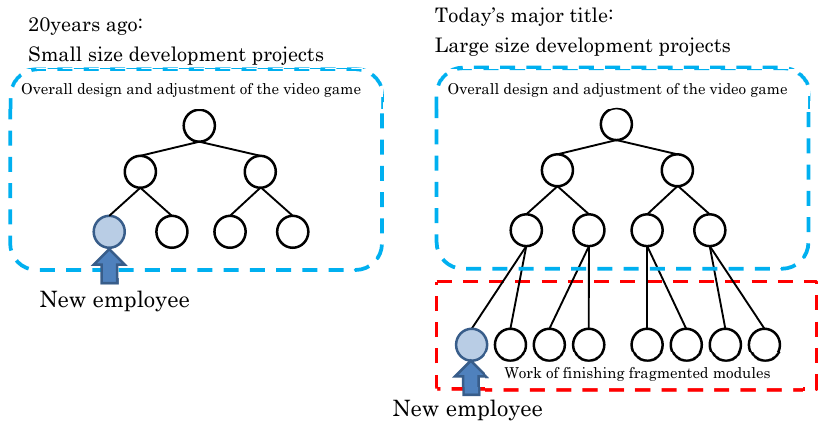
Figure 1. Differences in work given to new employees 20 years ago